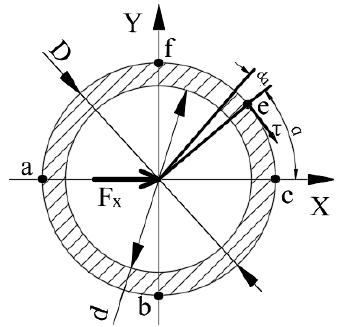
Figure 12. The shear stress analysis of the circular ring.